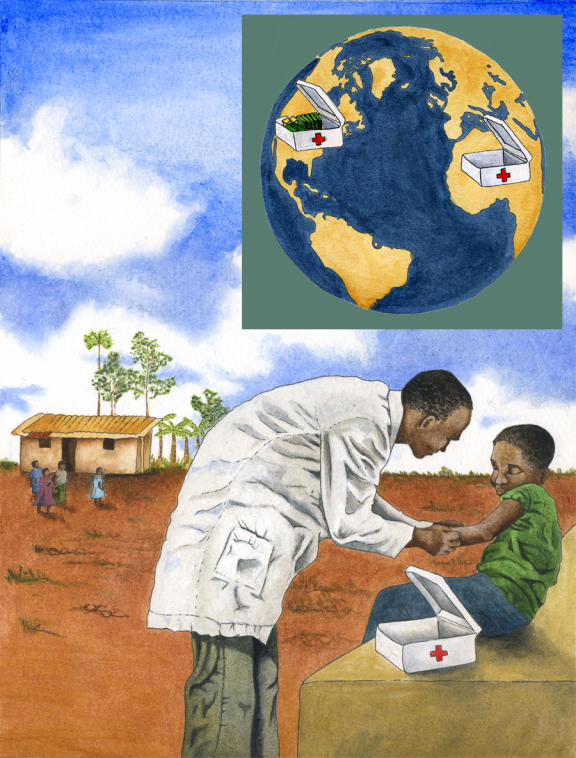
Vaccines won't reach their targets(Illustration: Emma Burns)